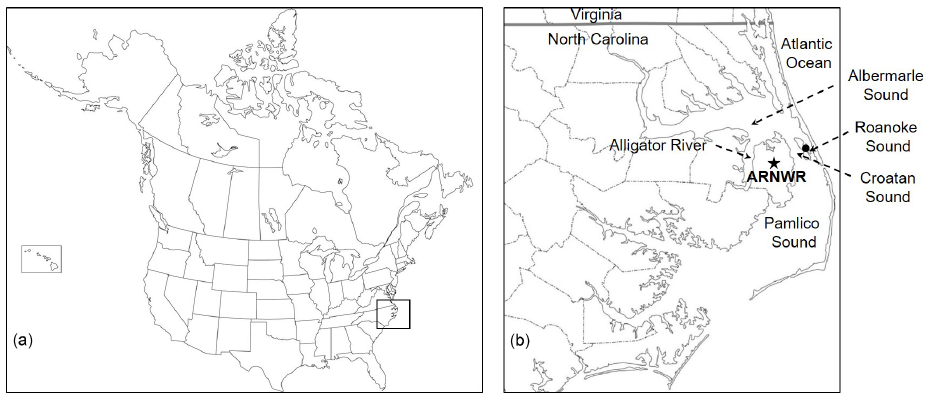
Figure 1. Location of the Alligator River National Wildlife Refuge (ARNWR) within North America ( a , indicated by box) and location of ARNWR within eastern North Carolina, USA, and surrounding freshwater (Alligator River and Albemarle Sound) and saltwater (Pamlico Sound, Croatan Sound, and Roanoke Sound) bodies (b) . Dotted arrows indicate the location of important surrounding water bodies. The star represents the approximate location of soil and freshwater (from Milltail Creek) sampling locations within the freshwater forested wetlands of ARNWR. The black circle represents the approximate location of saltwater sampling (at the Melvin Daniels Bridge, Roanoke Sound) from the Roanoke Sound. The saltwater was sampled approximately 32km east of the soil and freshwater